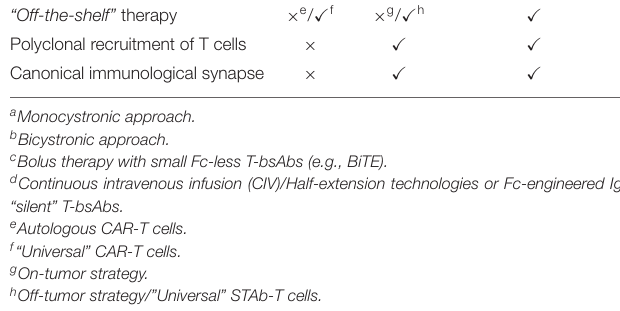
Adoptive cell Protein-based therapies therapies CAR-T STAb-T Systemic cells cells administration